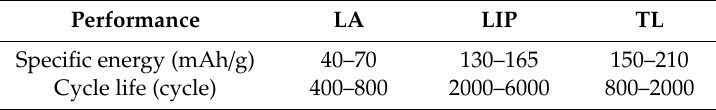
Table 2. Performance comparison for di ff erent